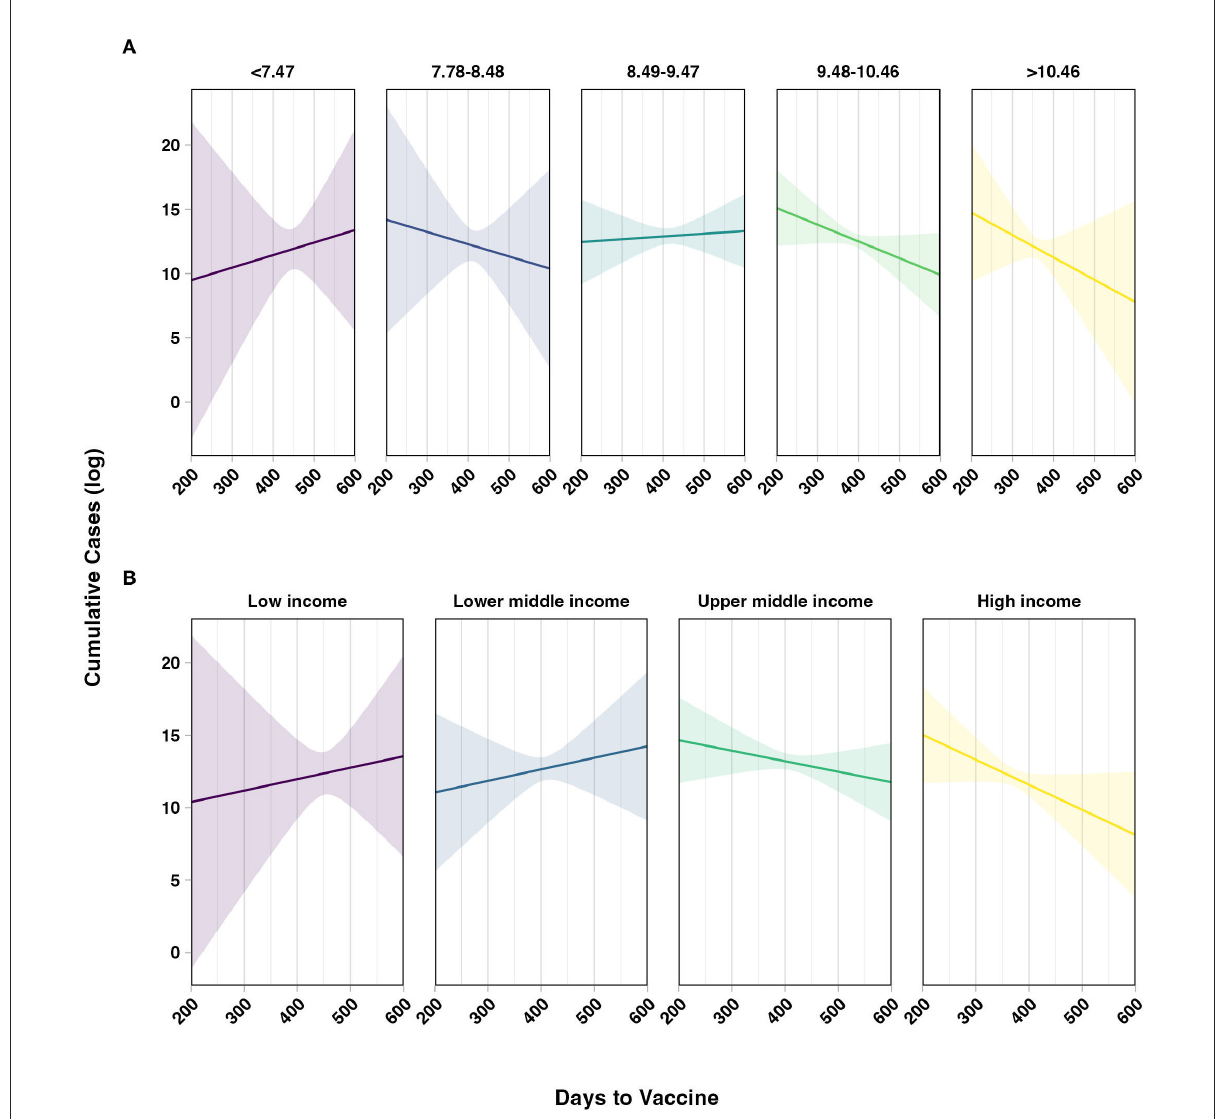
FIGURE3 Assessing the two-way interaction between economic size and days to first COVID-19 vaccine on estimated log-cumulative cases. (A) Economic size operationalized as world bank income classification. (B) Economic size operationalized as categorical log-GDP PPP per capita. Both models adjusted for 2021 population size, median age, and testing data availability (yes/no). Shaded bands indicate 95% prediction